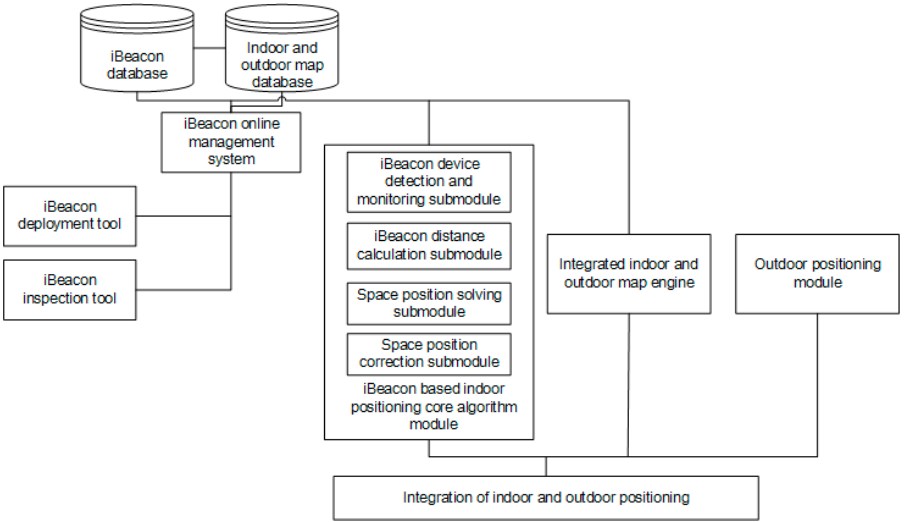
Figure 3. The framework of the integrated indoor and outdoor positioning system.